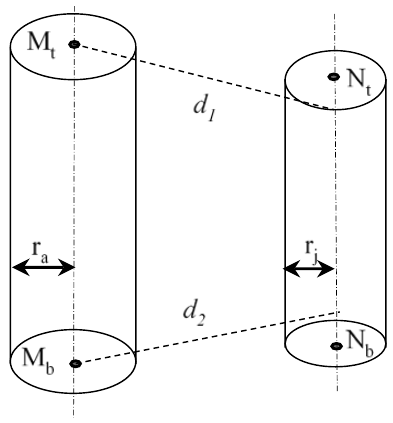
Figure 5. Collison checks between two capsules (two axes are parallel).